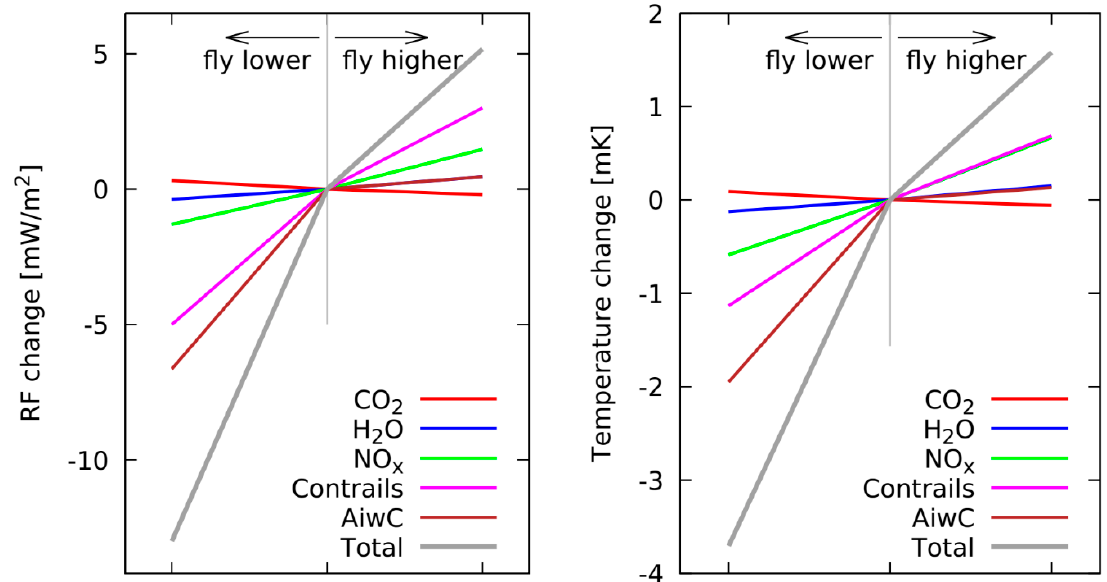
Figure 8. Change in radiative forcing [mW/m 2 ] ( left ) and change in temperature [mK] ( right ) assuming aircraft were always been Flying Lower and Flying Higher by 2000 ft compared to reference (base) case comprising direct water vapor (H 2 O), net nitrogen oxide induced impact (NO x ), contrail cirrus (contrails), aerosol indirect effect on warm clouds (AiwC).